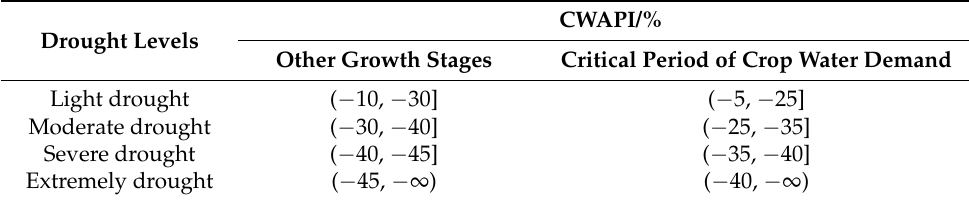
Table 1. Agricultural drought grades based on CWAPI. CWAPI/% Drought Levels Other Growth Stages Critical Period of Crop Water Demand Light drought ( − 10, − 30]